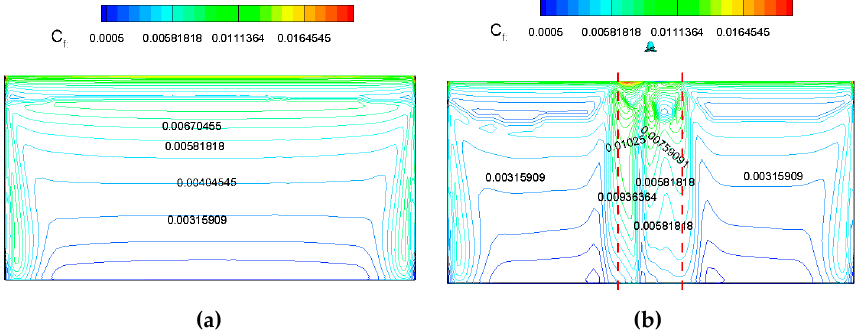
Figure 5. Variations of lift and drag coefficients of the wing for different Z R  : ( a ) Lift and drag coefficients versus Z R  ; ( b ) lift ‐ to ‐ drag ratio versus coe ffi cients versus ∆ Z / R ; ( b ) lift-to-drag ratio versus ∆ Z / R . ( Ma = 0.1017, α = 2 ◦ , Ω = 4400 r / min, medium grid). medium grid).